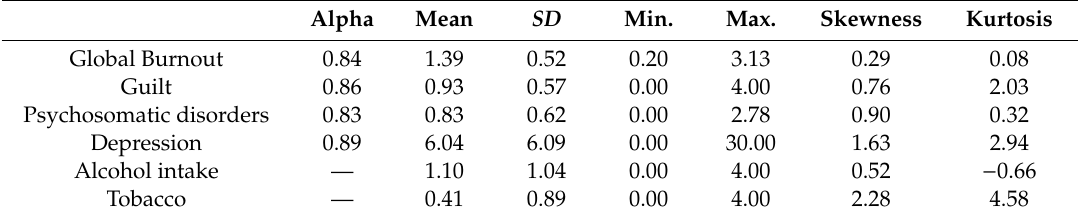
Table 1. Descriptive statistics for scales in the study ( n =